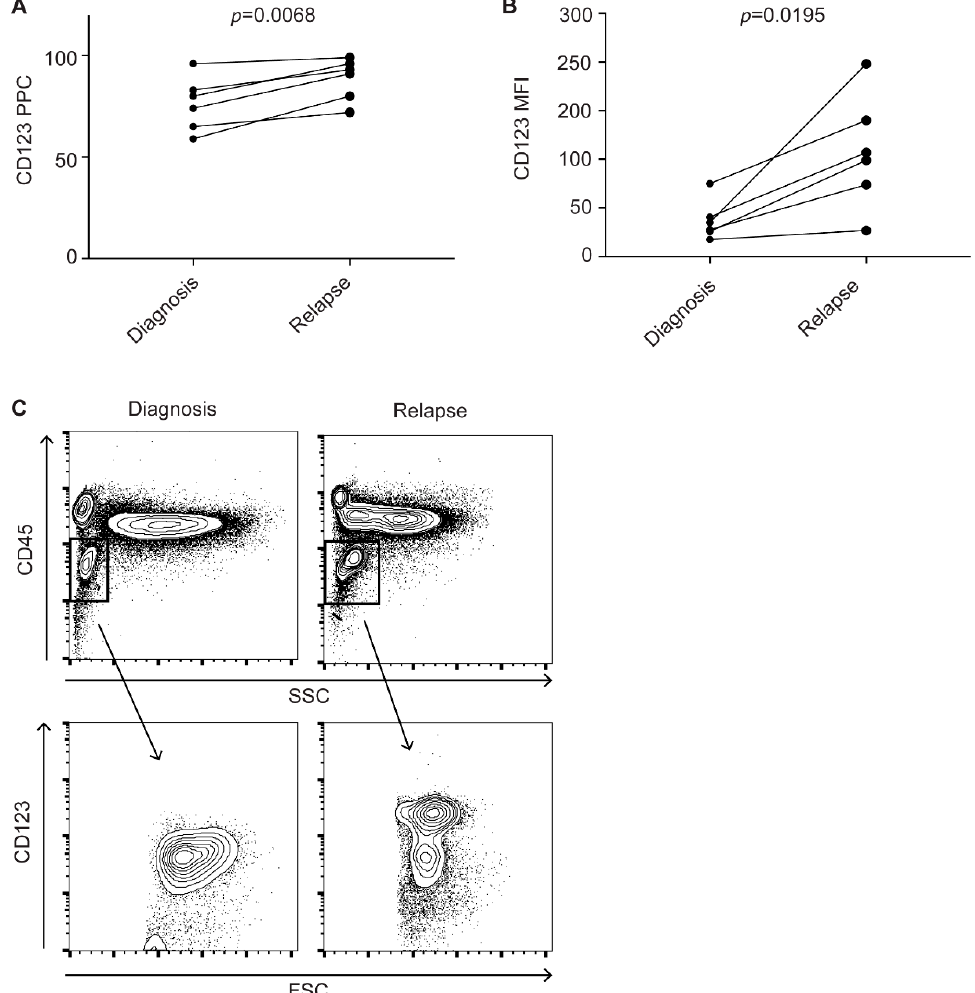
Figure 3. CD123 expression increases in relapsed NPM1 mut AML. ( A ) CD123 PPCs on bulk NPM1 mut AML cells at diagnosis and relapse ( n = 6). Paired t -test. ( B ) CD123 MFIs on bulk NPM1 mut AML cells at diagnosis and relapse ( n = 6). Paired t -test. ( C ) Flow cytometry dot plots showing an increase of CD123 expression at relapse (right plots) compared to diagnosis (left plots) in a representative case of NPM1 mut